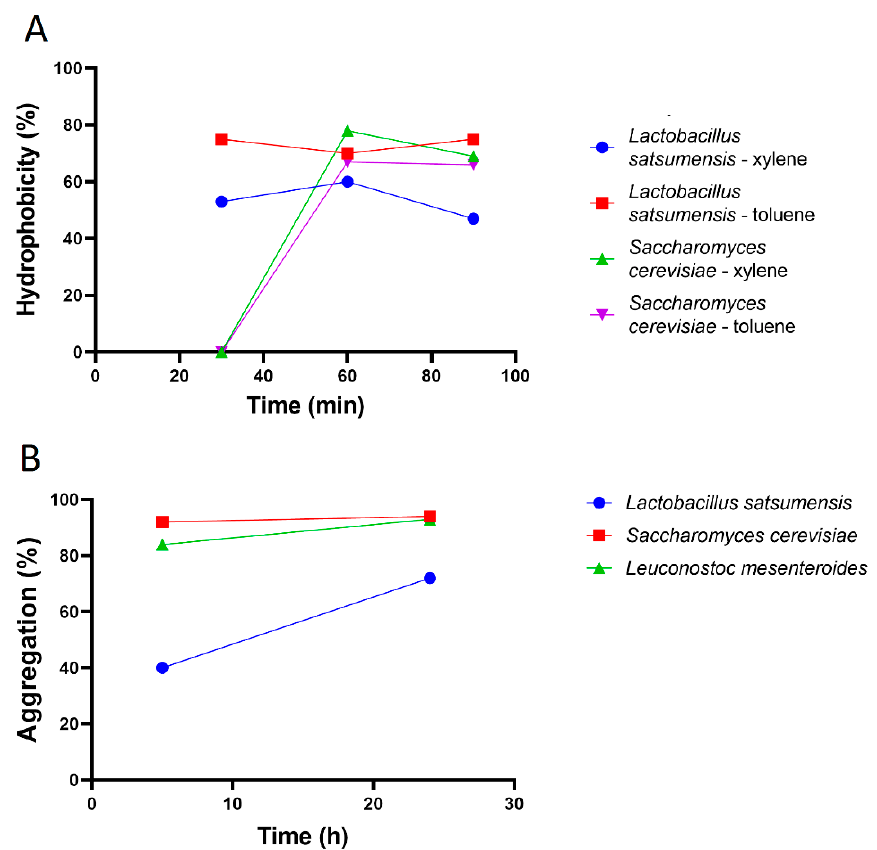
Figure 3. Hydrophobicity ( A ) of Lactobacillus satsumensis LPBF1 and Saccharomyes cerevisiae LPBF3 in 30, 60 and 90 min with xylene and toluene, and aggregation results ( B ) by 5 and 24 h. No hydrophobicity ability was observed for Leuconostoc mesenteroides LPBF2.